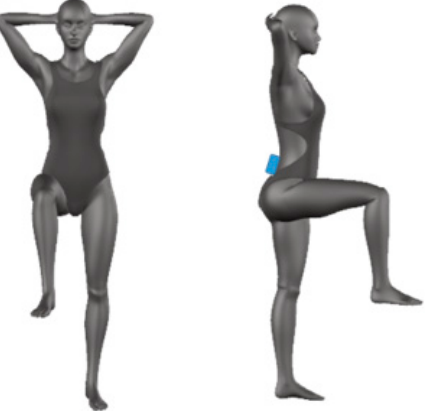
Figure 5. Balance test: positioning of the subject and sensor.